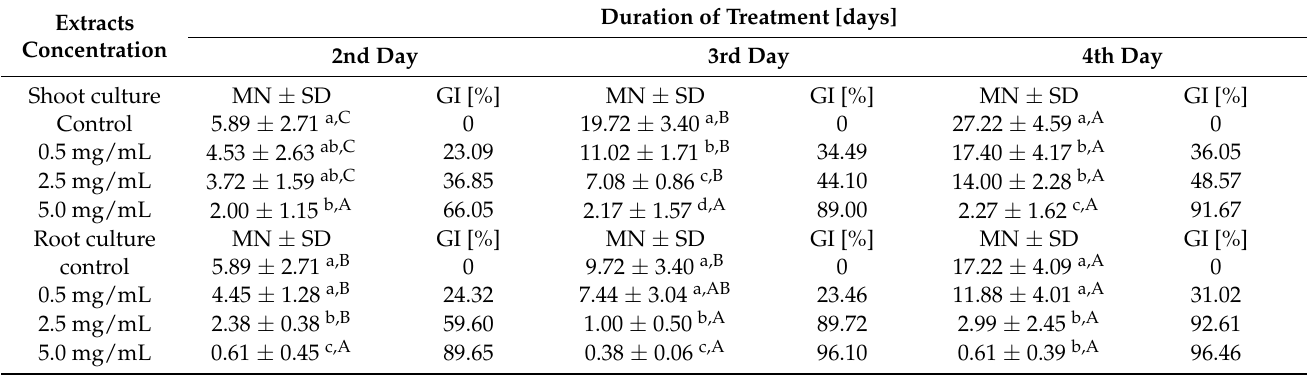
Table 6. Effect of extract from Eryngium maritimum shoot and root in vitro culture on inhibition of Acanthamoeba trophozoites during four days treatment.